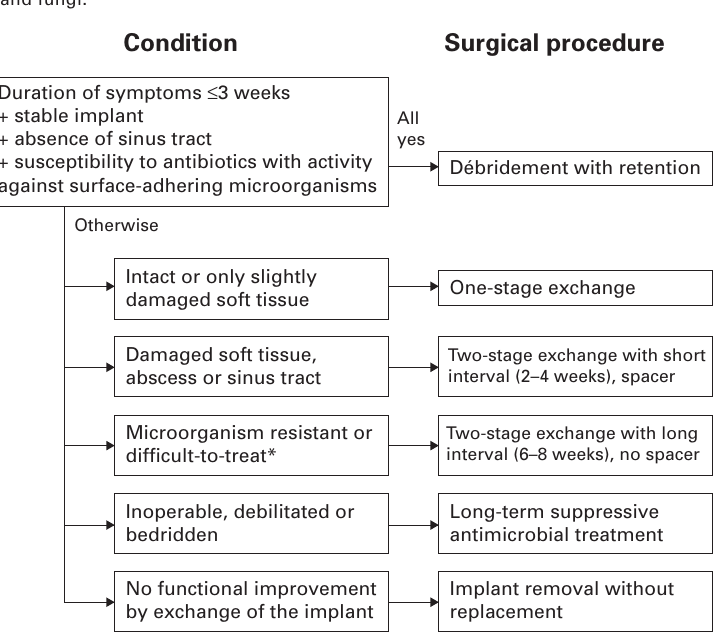
Surgical treatment algorithm for pros- thetic joint infections. * Difficult-to-treat microorganisms include methicillin- resistant S. aureus (MRSA), small- colony variants of staphylococci, ente- rococci, quinolone- resistant Pseudo- monas aeruginosa and